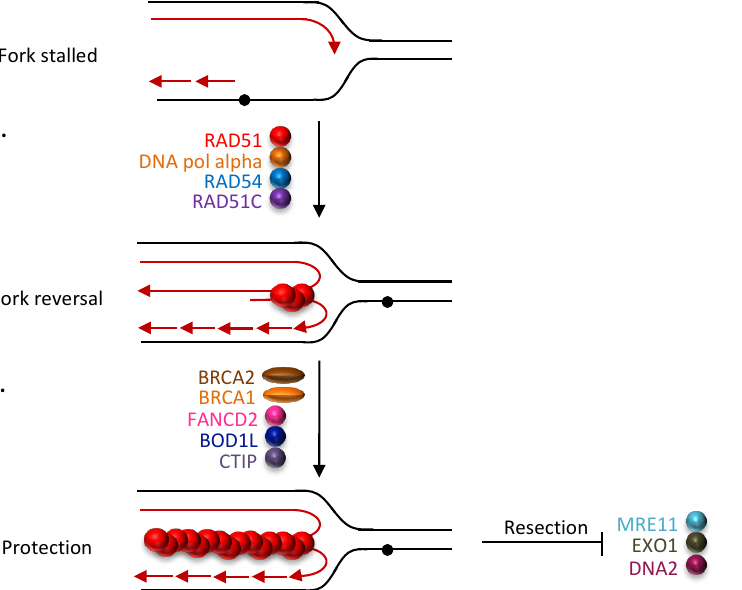
Figure 3. RAD51 and replication forks. A. RAD51 is required for the reversal of the fork. The recruitment, mediated by direct interaction with DNA pol alpha, RAD54 and/or RAD51c creates a four-branch structure called « chicken foot ». BRCA2 is not needed at this stage. B. RAD51 protects against the resection initiated by MRE11 and then EXO1/DNA2. Moreover, BRCA2, BRCA1, FANCD1, BOD1 and also CTIP are required for fork protection.